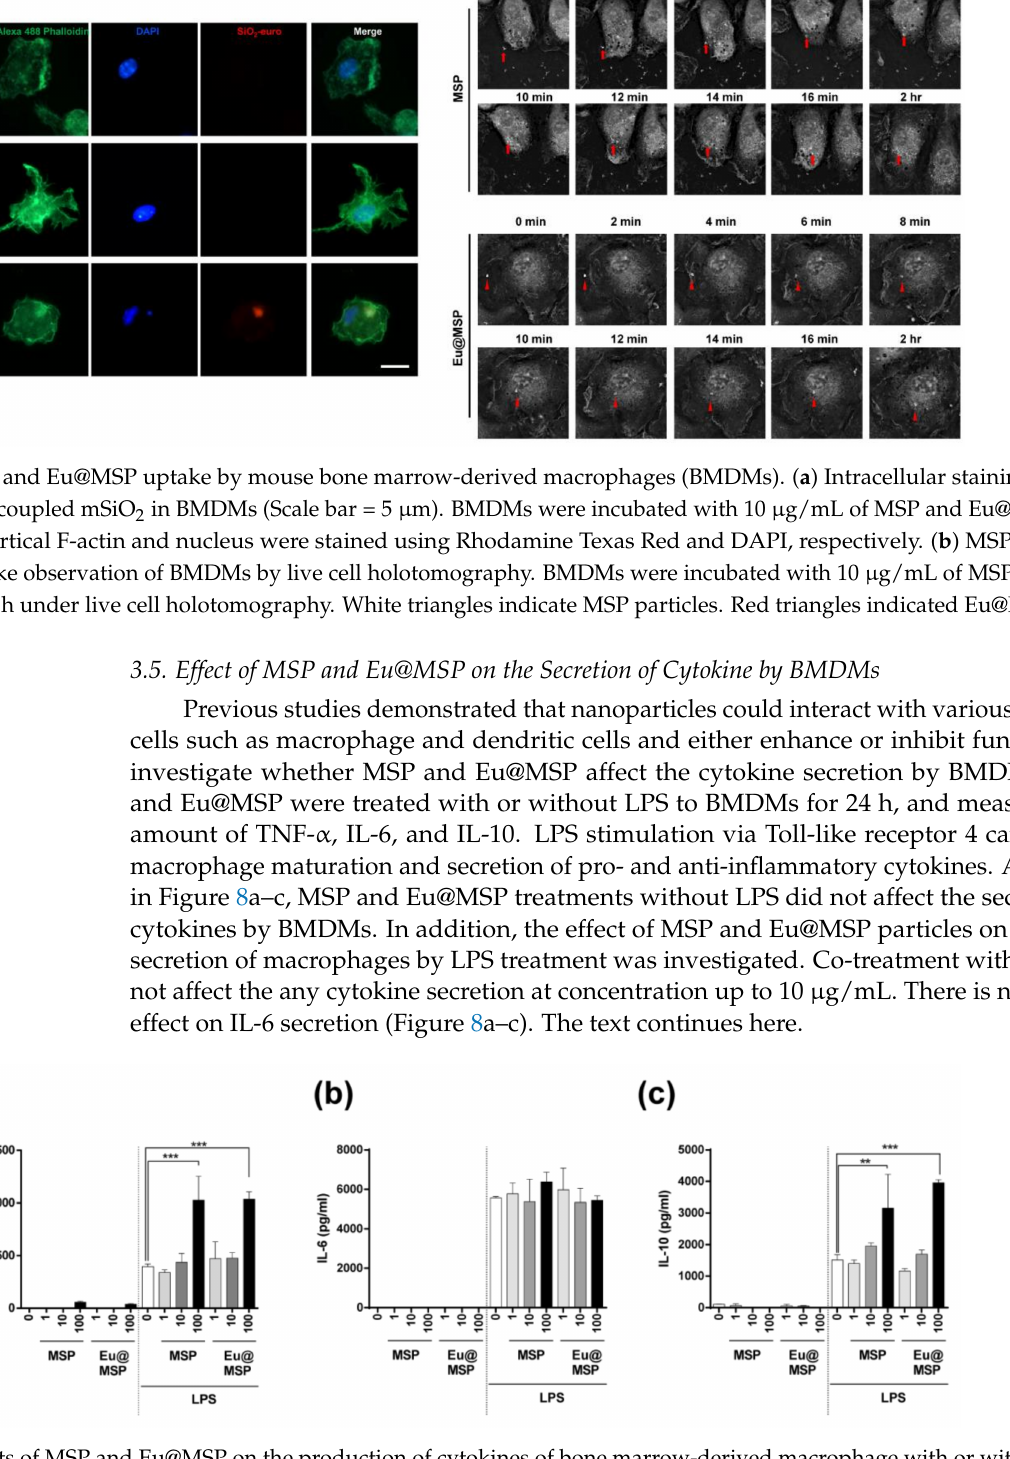
Figure 8. Effects of MSP and Eu@MSP on the production of cytokines of bone marrow-derived macrophage with or without lipopolysaccharide stimulation. The production of TNF- α ( a ), IL-6 ( b ), and IL-10 ( c ) in the supernatant was measured by ELISA. BMDMs were treated with or without LPS (100 ng/mL) and MSP and Eu@MSP for 24 h at the indicated concentration. All data represented the mean ± standard deviation, n = 4 (** < 0.05 and *** <